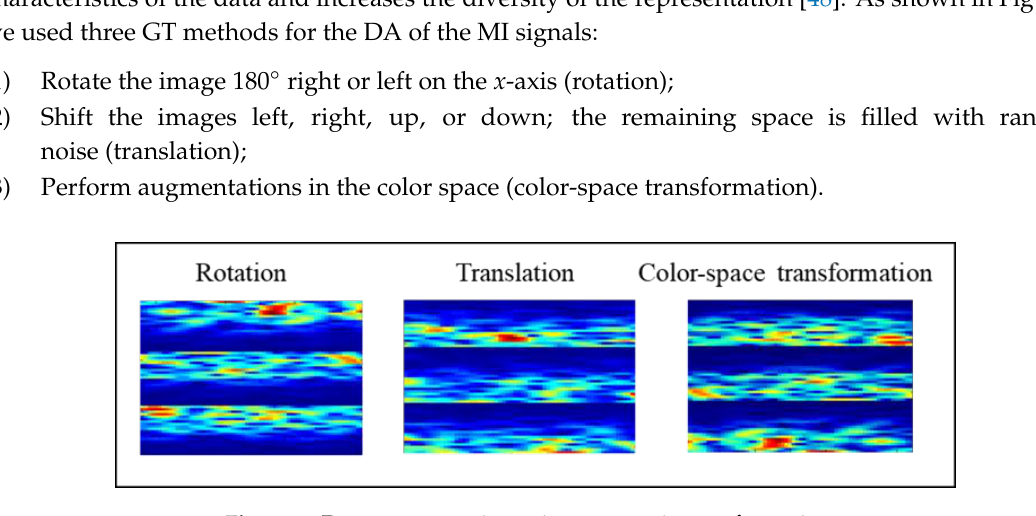
Figure 4. Data augmentation using geometric transformations.